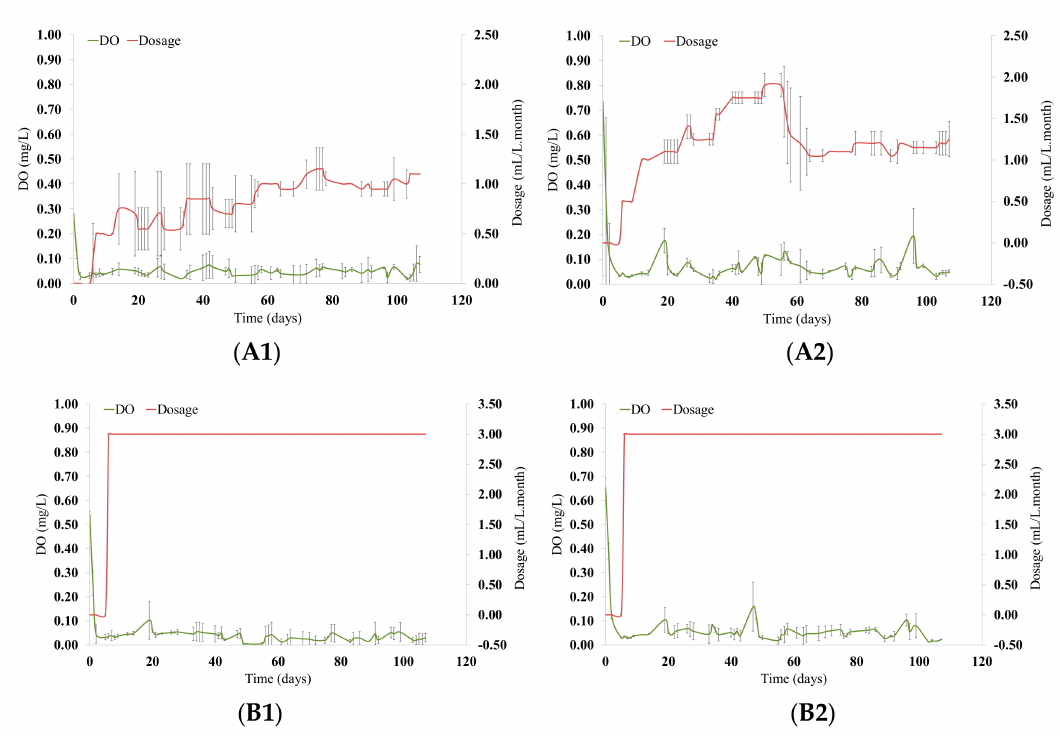
Figure 2. Graphic representation of dissolved oxygen (mg/L) and MOX dosage (mL/L · month) of wines treated with two micro-oxygenation strategies: ( A ) floating MOX strategy, in which the setpoint was set at 50 µ g/L; ( B ) fixed MOX strategy with 3 mL/L · month. The wood chips were added at two different moments: ( 1 ) all the wood at the beginning of the maturation process; ( 2 ) half of the wood at the beginning and the other half 48 days after the beginning of the